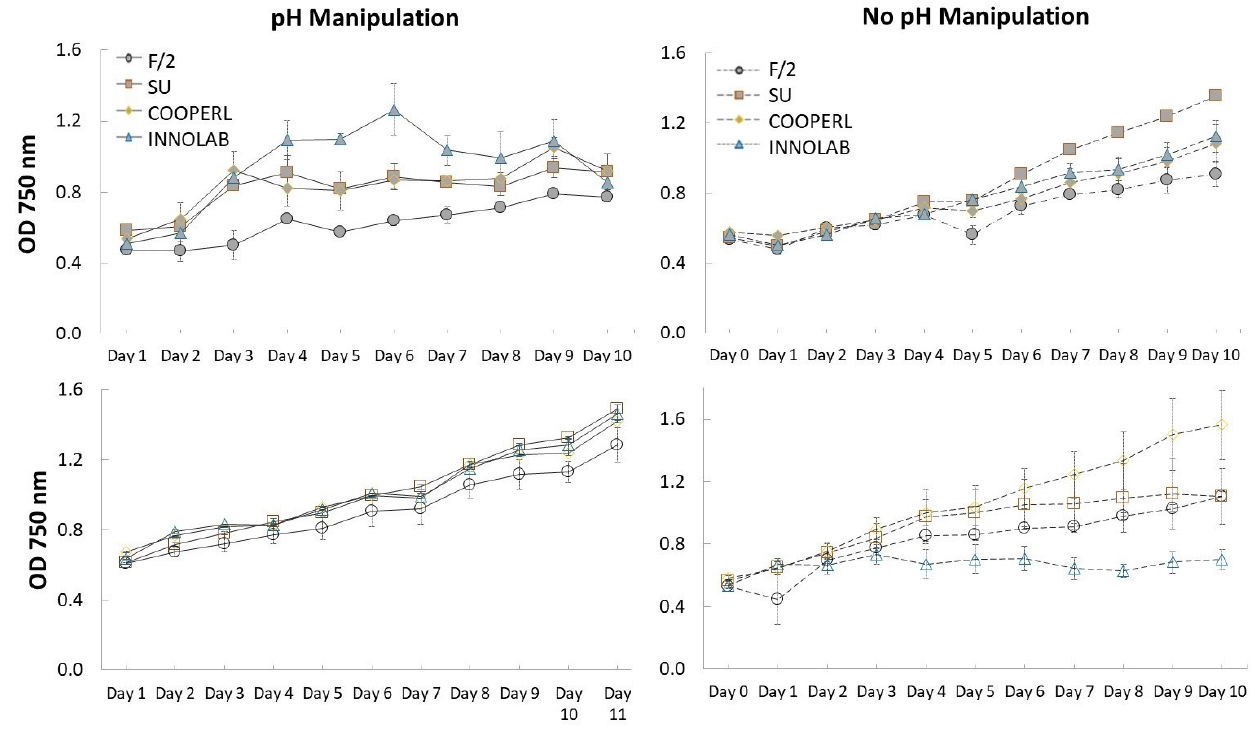
Figure 1. Absorbance at 750 nm for C. vulgaris and S. obliquus grown on three different digestates under pH manipulation and no pH manipulation for 10 days of the experiment. Error bars represent the standard deviation on three replicates.